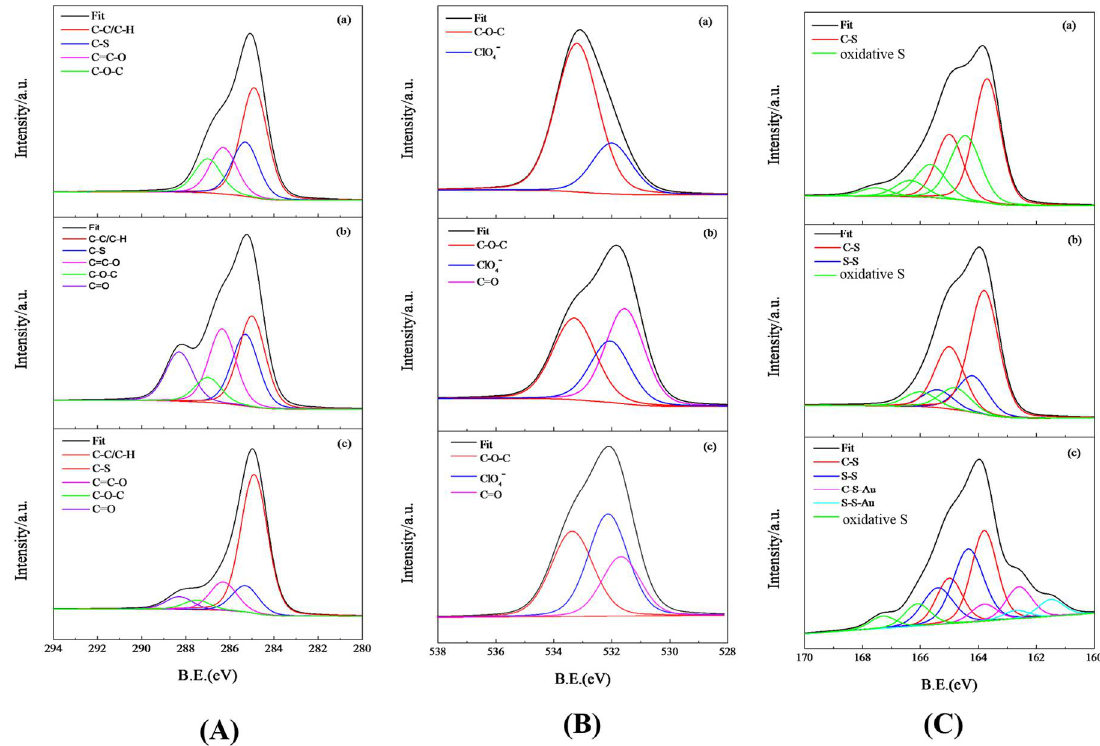
Figure 7. The fitting curves of deconvoluted spectra of XPS for ( A ) C 1s, ( B ) O 1s, and ( C ) S 1s, with ( a ) PEDOT/Pt, ( b ) PEDOT:BSA/Pt, and ( c ) AuNPs/PEDOT:BSA/Pt electrodes in each column.